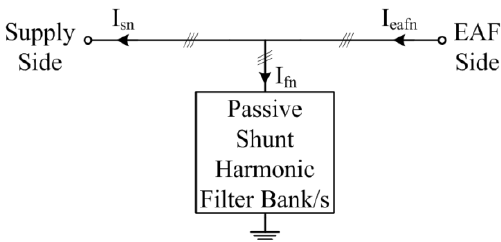
Figure 1. Block diagram illustrating all harmonics and interharmonics of an EAF power system. ( I eafn , I sn , and I fn denote the harmonics and interharmonics injected by the EAF, all harmonic and interharmonic components in the supply lines, and harmonic and interharmonic components sunk by the passive shunt harmonic filter bank/s, respectively).